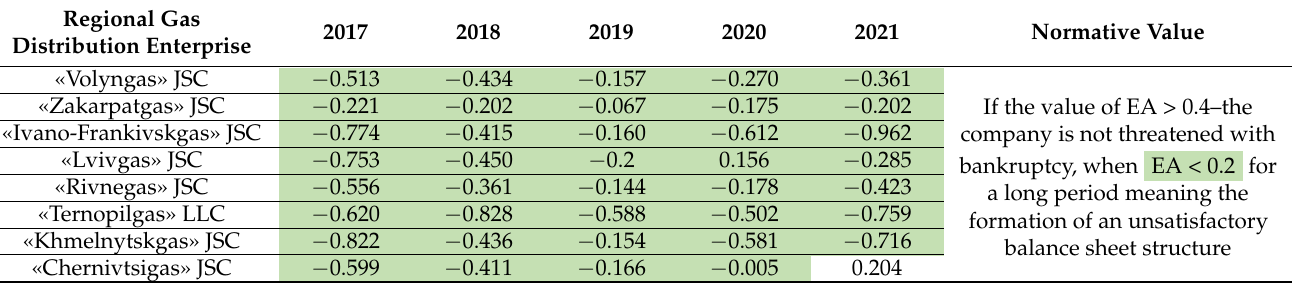
Table 8. Beaver’s coefficient